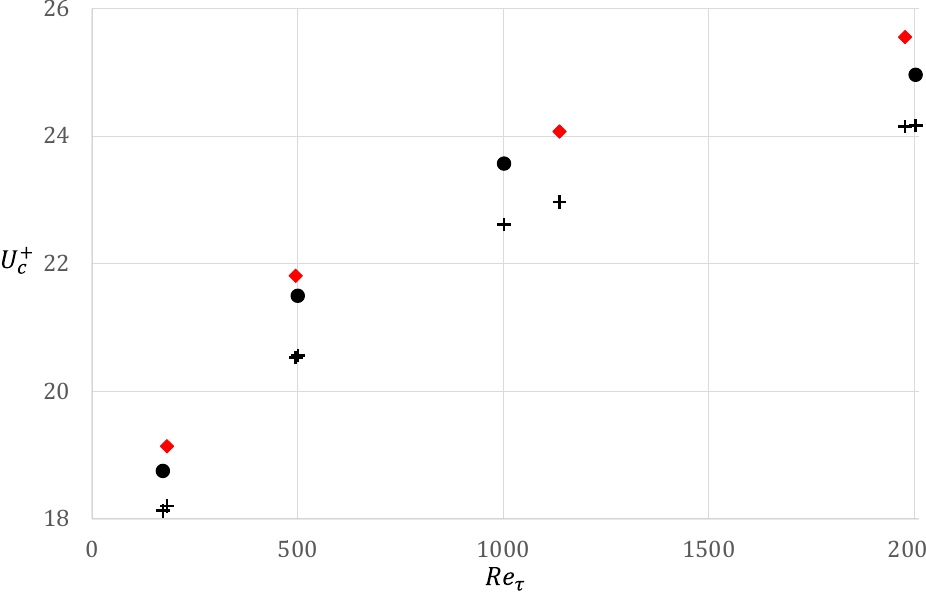
2000 pipe DNS data [31,32]; and ♦